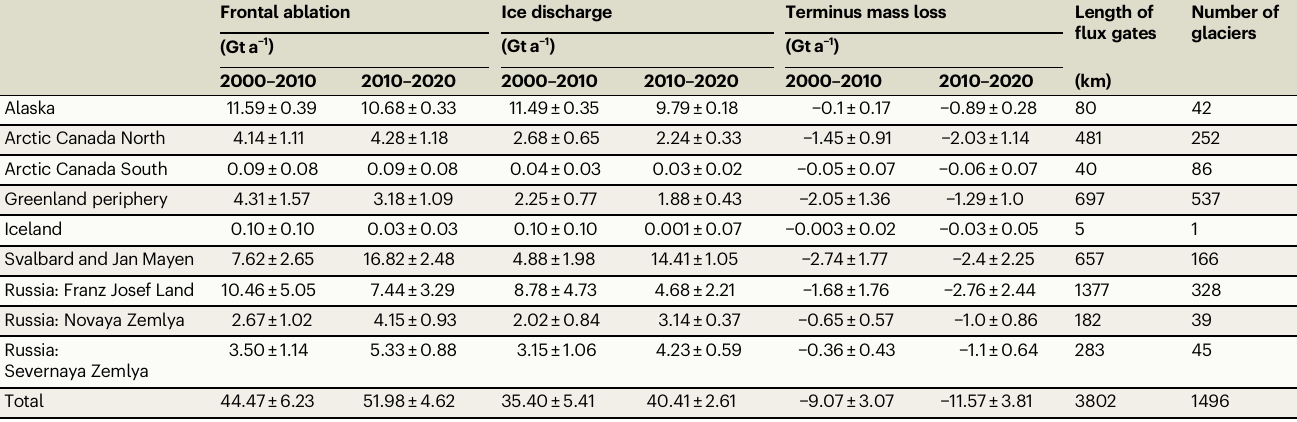
Table 1 | Frontal ablation and